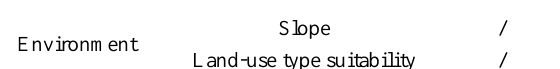
Table 5. The relationship between WER and